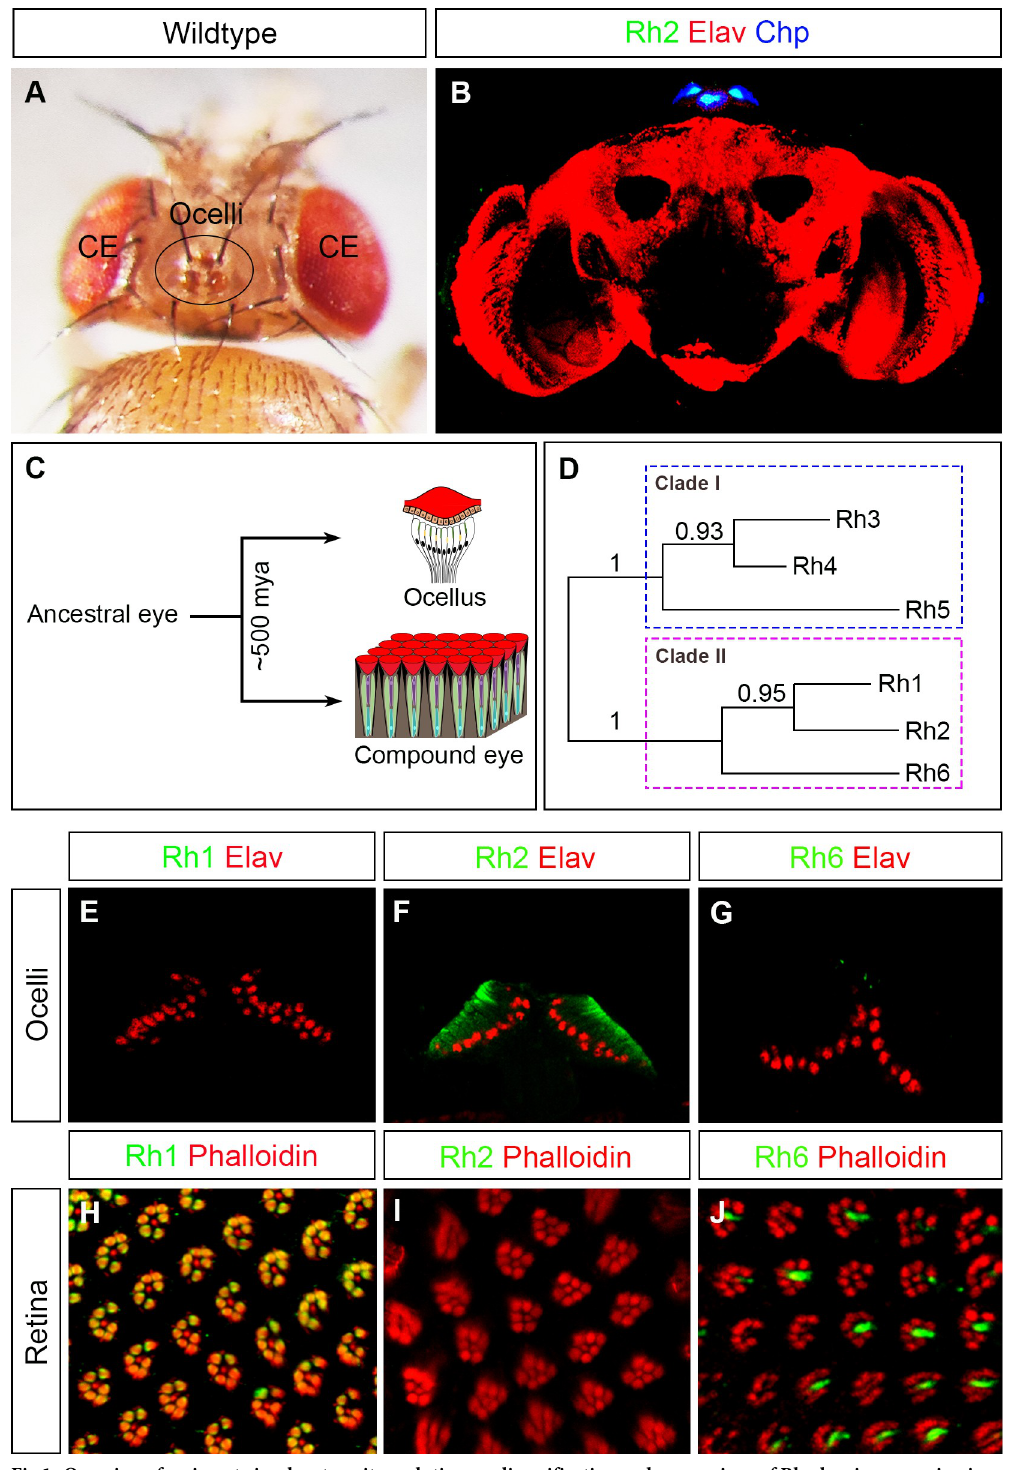
Fig 1. Overview of an insect visual system, its evolutionary diversification and comparison of Rhodopsin expression in the Drosophila ocelli and compound eye. (A) Dorsal view of the head of a fruit fly showing the positions of compound eye (CE) and ocelli (black circle; Image provided by Abhishek Kumar Mishra). (B) Cross section of a Drosophila adult brain where ocelli are marked by expression of Rh2 (in green). Chp expression (in blue) marked ocellar PRs and Elav expression (in red) marked neuronal population (C) Schematic representation of a morphological bifurcation event that occurred over 500